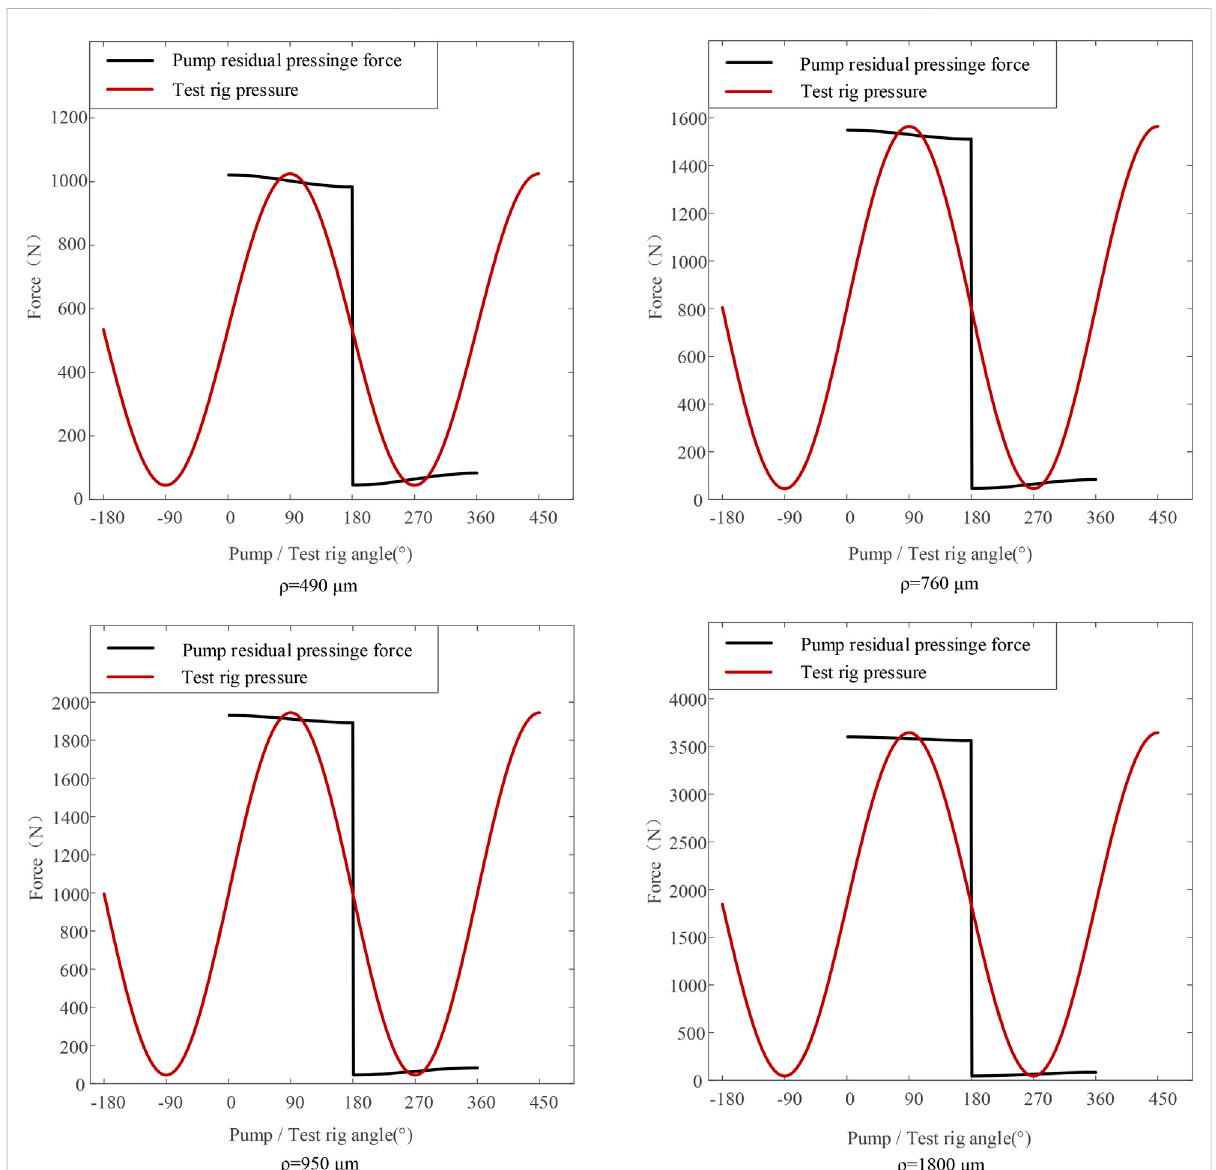
FIGURE 11 Fitted plot of the magnitude and variation of the test setup compression force at q =